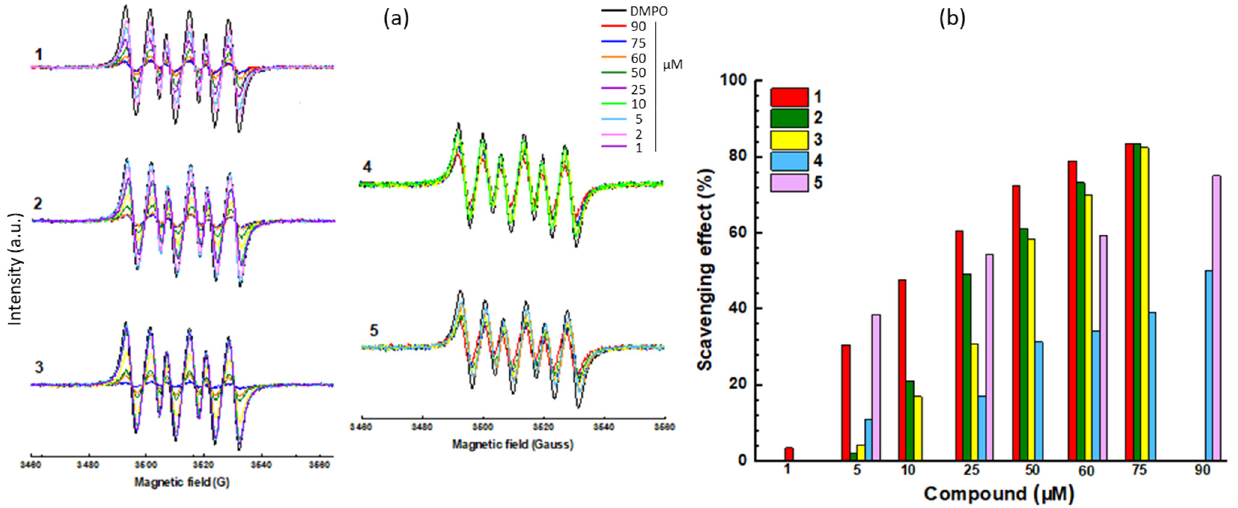
Figure 7 Radical scavenging: ( a ) EPR spectra of the radical DMPO/ • OCH 3 with increasing amounts of the titled compound. ( b ) Scavenging e ff ect (%) of the compounds. DMPO was used at 1 mM and the compound concentration varied from 1 to 75 or 90 µM. The scavenging e ff ect (%) is de fi ned by the ratio (area DMPO-OMe − (area Cpd + area DMPO-OMe ))/area DMPO-OMe .